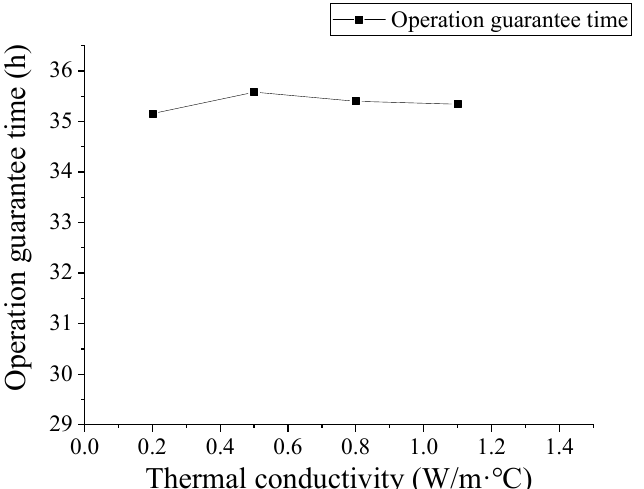
Figure 15. Effect of thermal conductivity on the guaranteed operation time of the reservoir.